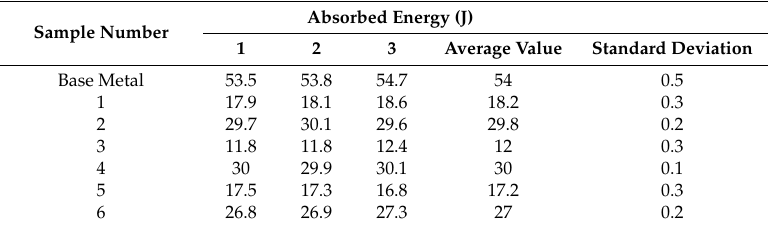
Table 4. Charpy impact test results of joint and base